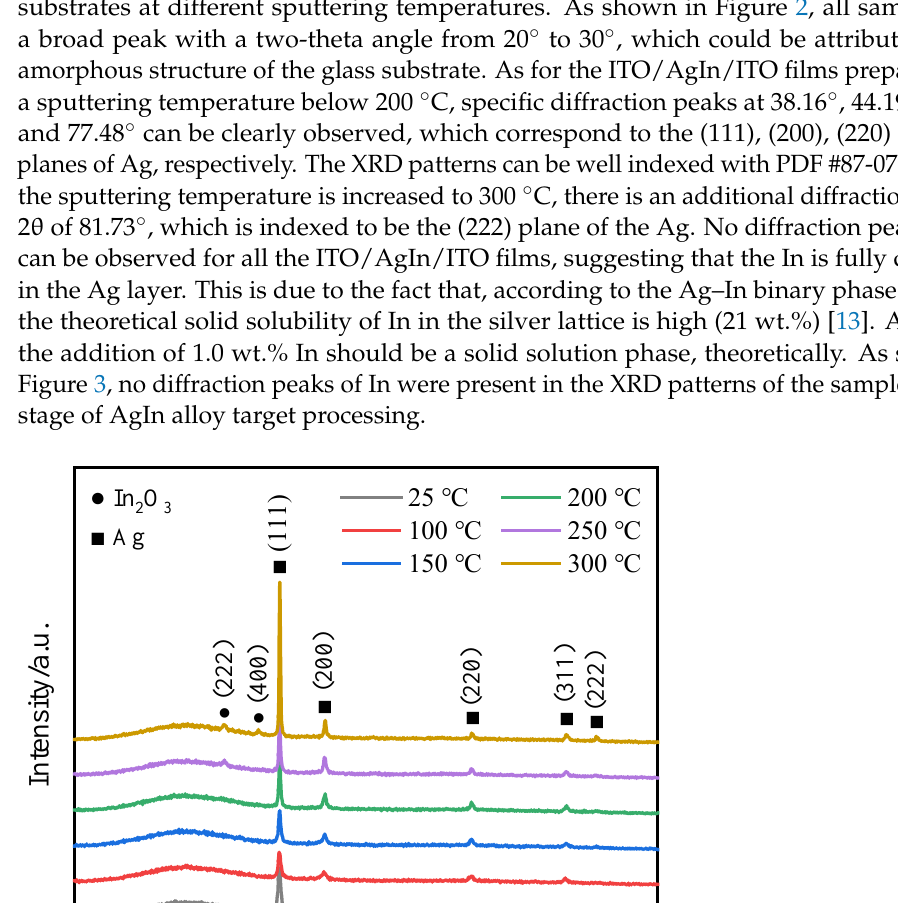
Figure 3. XRD patterns of as - cast, forging and final AgIn alloy targets . Figure 4 depicts the reflectance spectra of the ITO/AgIn/ITO films as a function of sputtering temperature. At a certain sputtering temperature, the reflectance gradually increases with increasing wavelength. The reflectance decreases sequentially with increasing sputtering temperature at 550 nm. The films prepared at 25 °C had the highest reflectance, up to 95.3% at 550 nm and 98.6% at 780 nm. The films prepared at 100 °C had an approximate reflectance, but the average reflectance in the visible wavelength range of 380 – 780 nm was slightly lower than the reflectance at 25 °C. The reflectance at 550 nm at 150 °C, 200 °C, 250 °C and 300 °C was 92%, 78.8%, 68.6% and 69.3%, respectively.